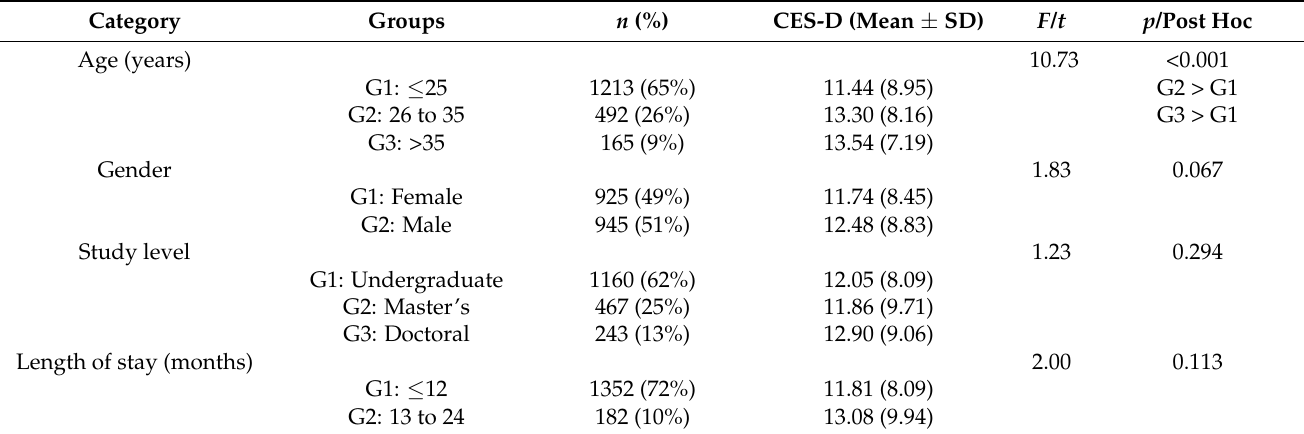
Table 1. Participants’ demographics and the distribution of